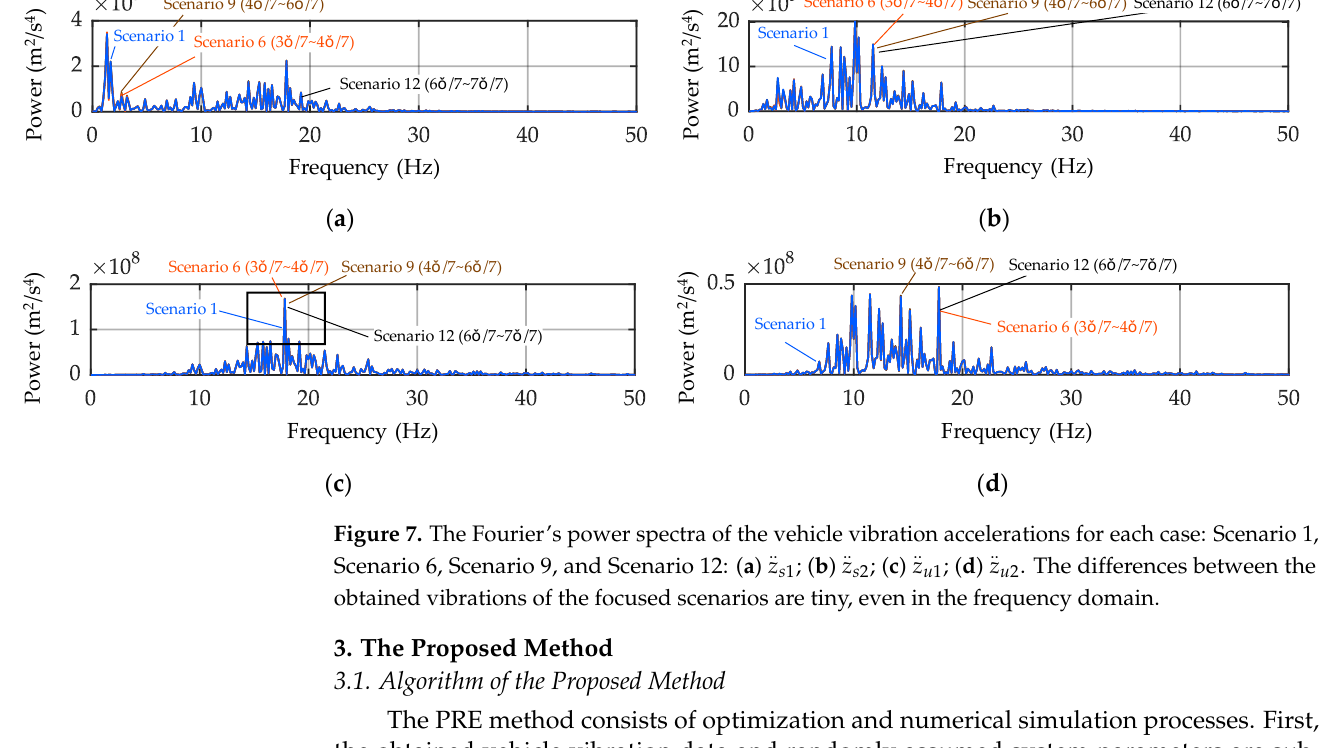
the obtained vibrations of the focused scenarios are tiny, even in the frequency domain.